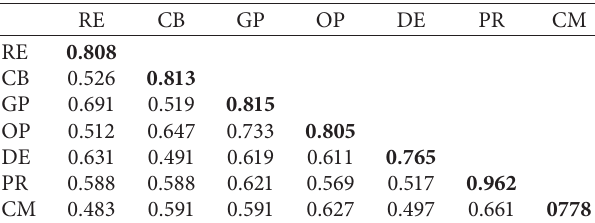
Table 11: Discriminant validity test